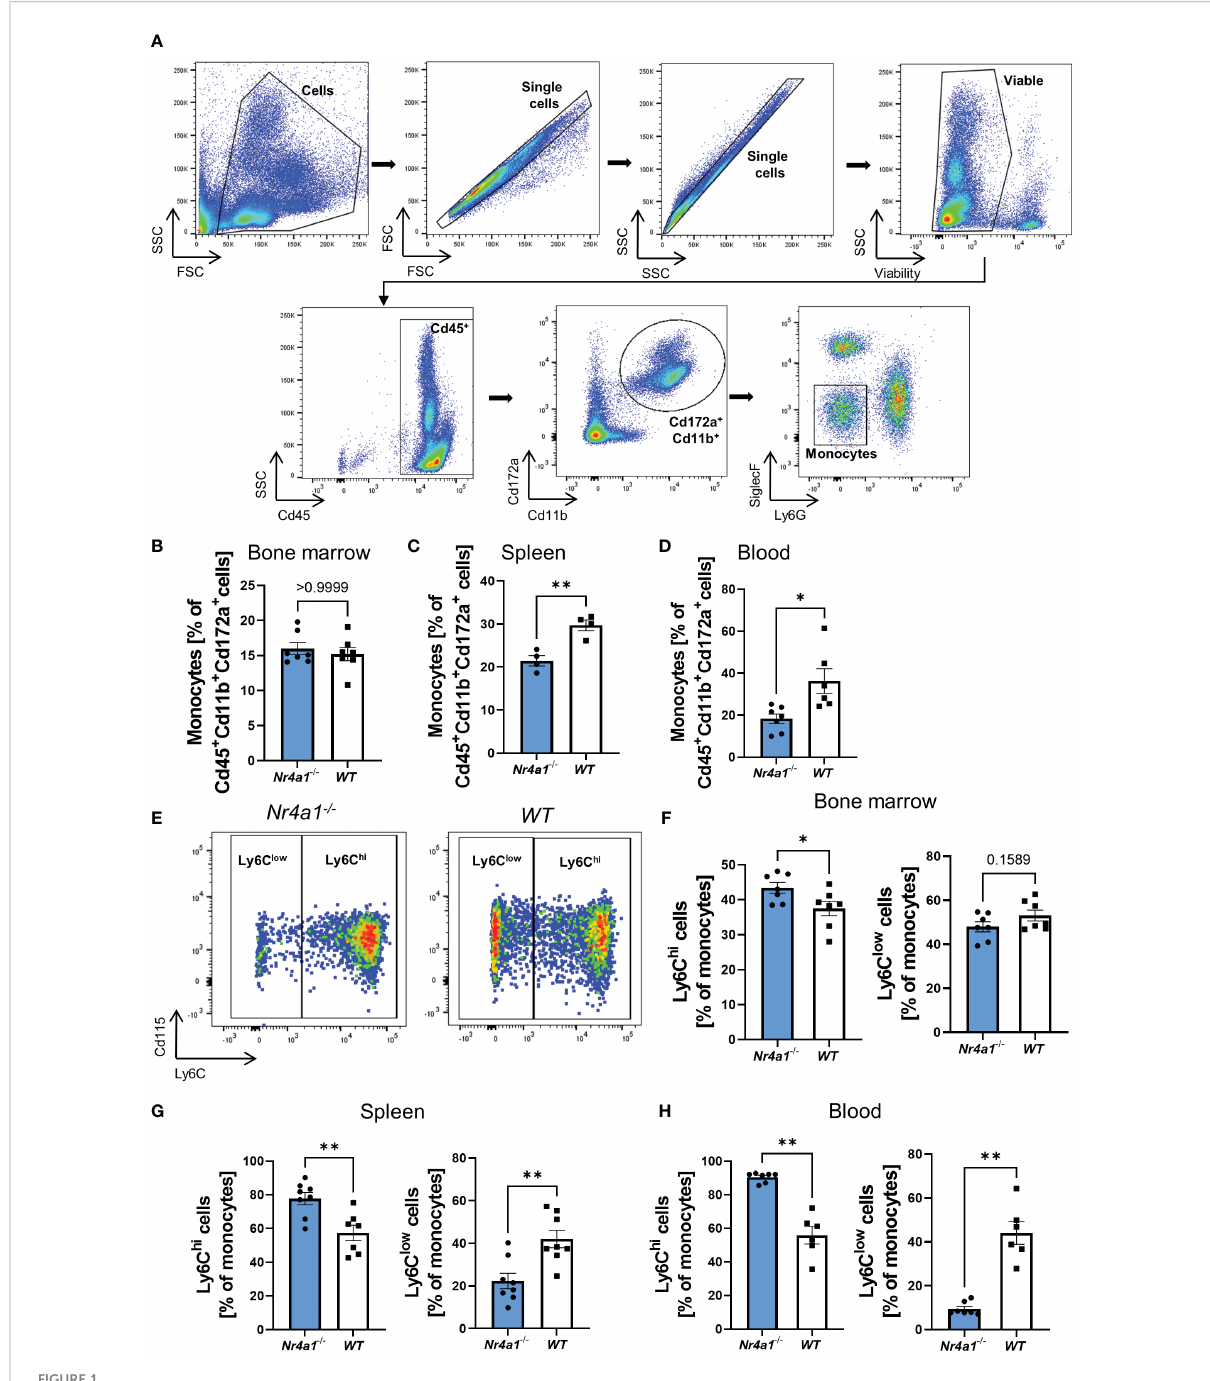
FIGURE 1 Depletion of non-classical monocytes in Nr4a1 -/- mice. (A) Representative gating strategy for the identi fi cation of monocytes. Cells were gated based on forward and side scatter before selecting single cells and viable cells. Monocytes were de fi ned as Cd45 + Cd11b + Cd172a + Ly6G - SiglecF - . (B – D) Abundance of monocytes in the bone marrow (B) , spleen (C) and peripheral blood (D) gated as shown in (A) . (E) Representative gating for Ly6C hi and Ly6C low monocyte subsets in the peripheral blood of Nr4a1 -/- and WT mice as % of monocytes. (F – H) Quantitative analysis of the different monocyte subsets in Nr4a1 -/- and WT mice in the bone marrow (n=7) (F) , the spleen (n=8-9) (G) and the peripheral blood (n=6-7) (H) . * p < 0.05, ** p <